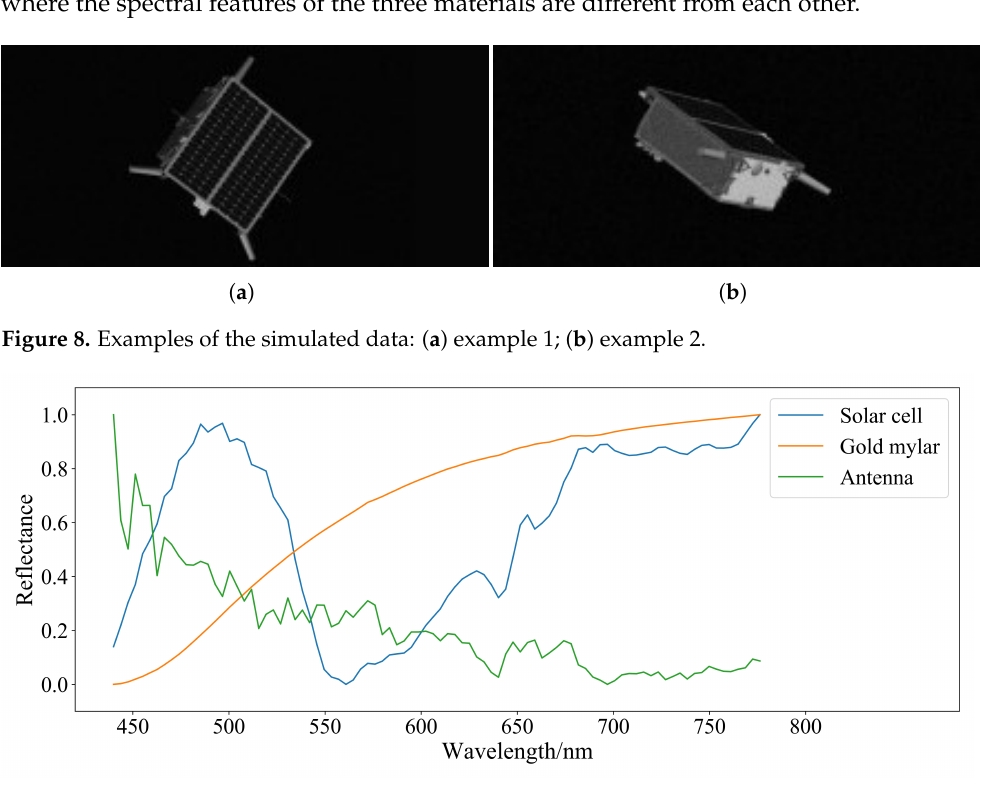
Figure 9. Examples of normalized materials’ spectra in the simulated